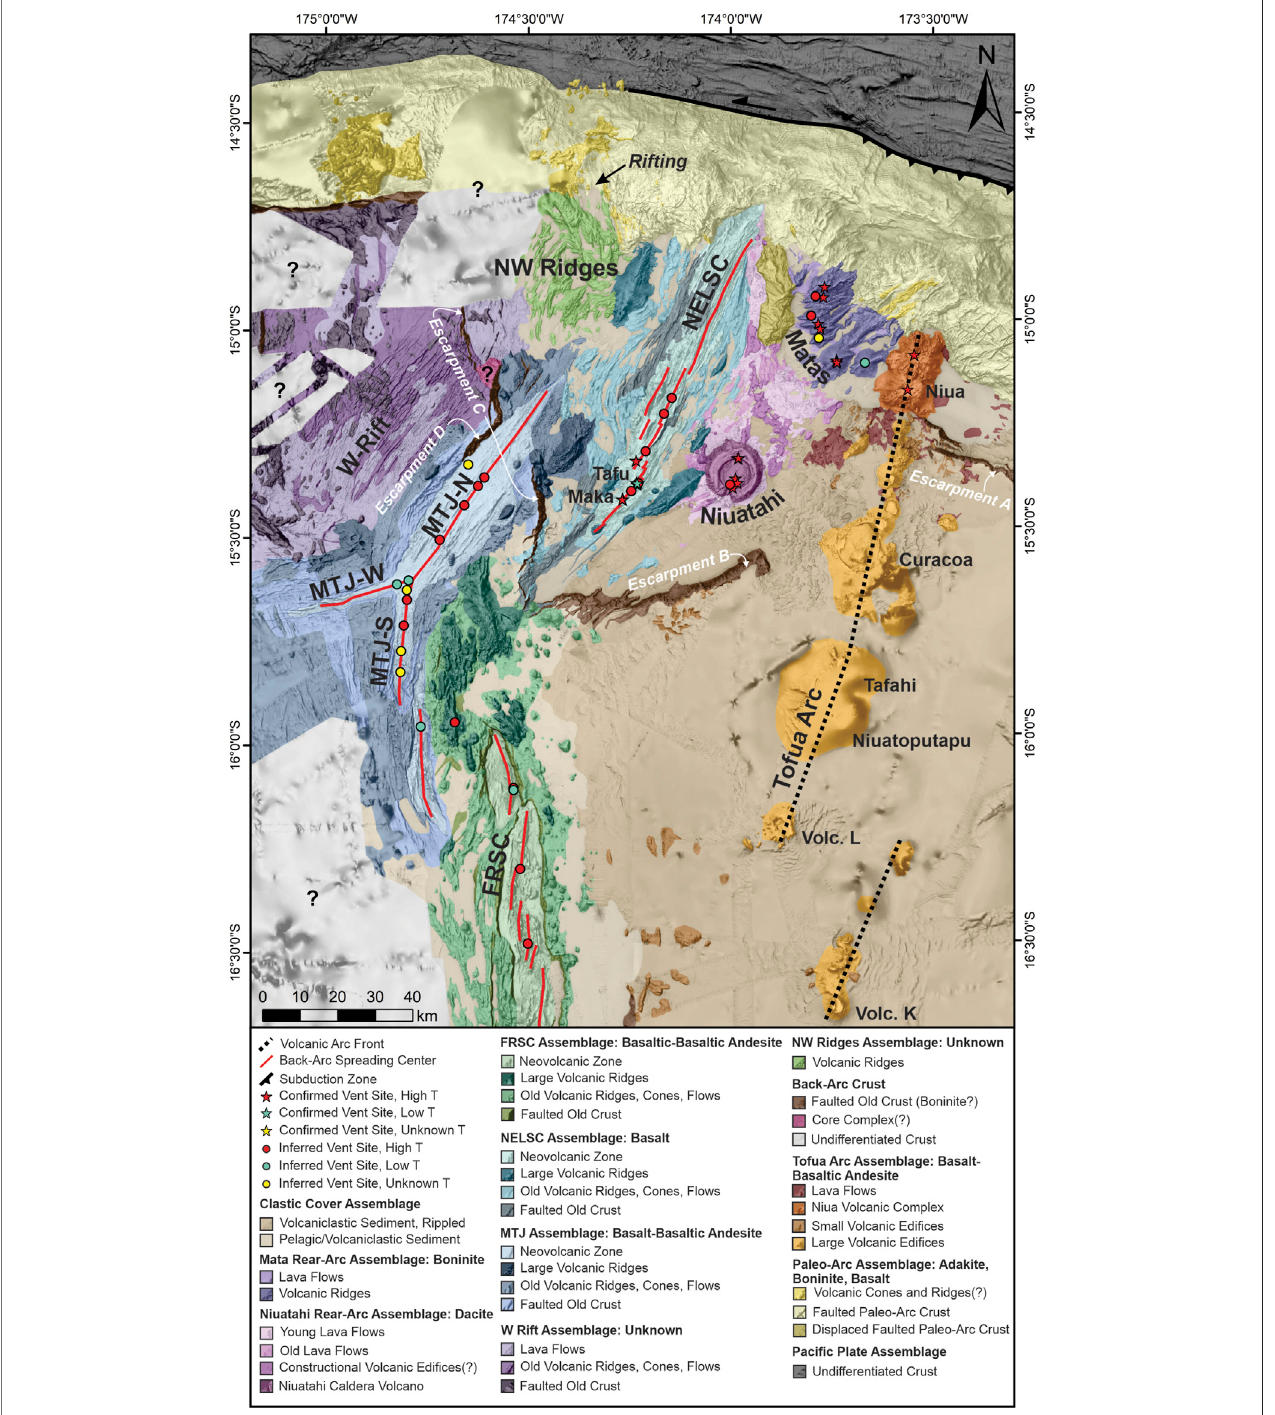
FIGURE 5 | Remote-predicted geological map of the NE Lau basin interpreted from sea fl oor geomorphology and limited sampling ( Supplementary Figure S3 ), overlain on a compilation of ship multibeam bathymetry (compilation data as in Figure 3 ). Hydrothermal vent sites compiled from the FK171111 and SO-263 cruises (Haase and Shipboard Scienti fi cParty, 2018;Rubinand Shipboard Scienti fi cParty, 2018),InterRidge VentsDatabase v.3.4(Beaulieu and Szafranski,2019),and Baker et al. (2019). “ Matas ” refers to the Mata volcanoes; other abbreviations as in Figure 2 . Additional details on map units outlined in Supplementary Table S2 , lithologies based on sampling shown in Supplementary Figure S3